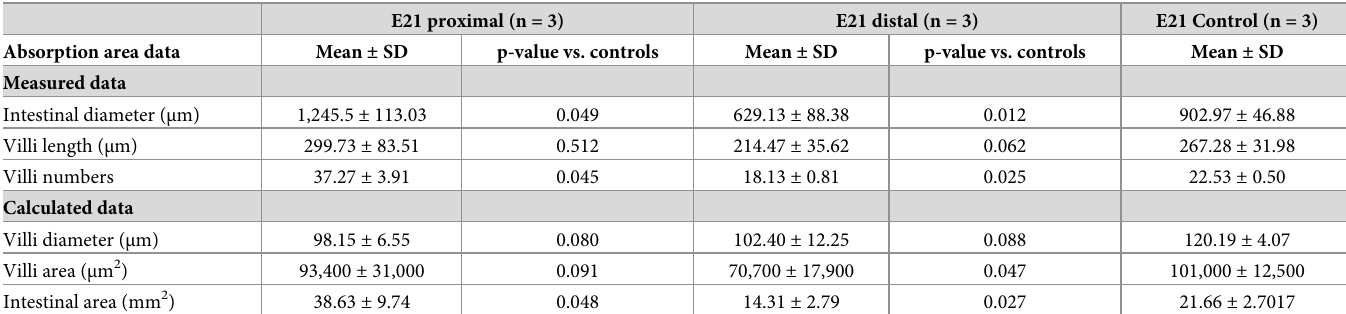
Table 3. Morphometric results for the intestinal absorption